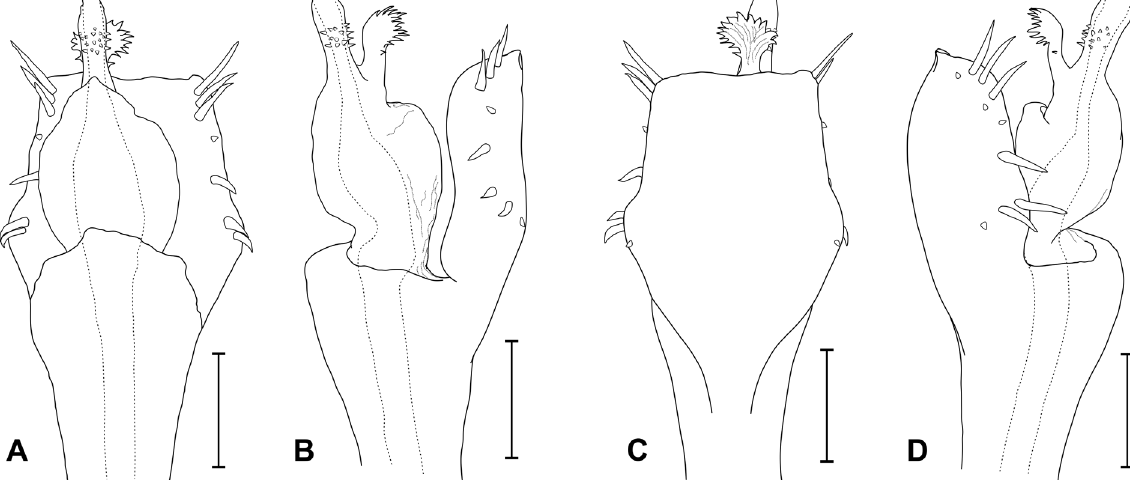
Fig. 18. Lacronia serripes (Mello-Leitão, 1923), ♂ (MNRJ 9973), penis, distal part. A . Dorsal view. B . Right lateral view. C . Ventral view. D . Left lateral view. Scale bars = 100